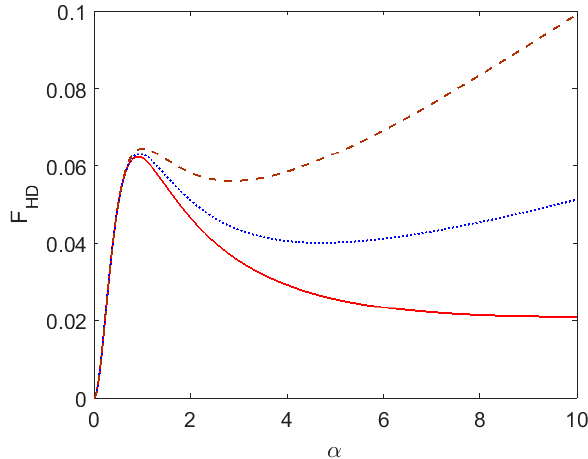
Figure 6. Stark–Doppler absorption probability F HD as a function of pulse duration parameter α for zero detuning δ = 0 and various values of parameter ξ : solid line − ξ = 0.1, dotted line − ξ = 0.2, dashed line − ξ = 0.3.